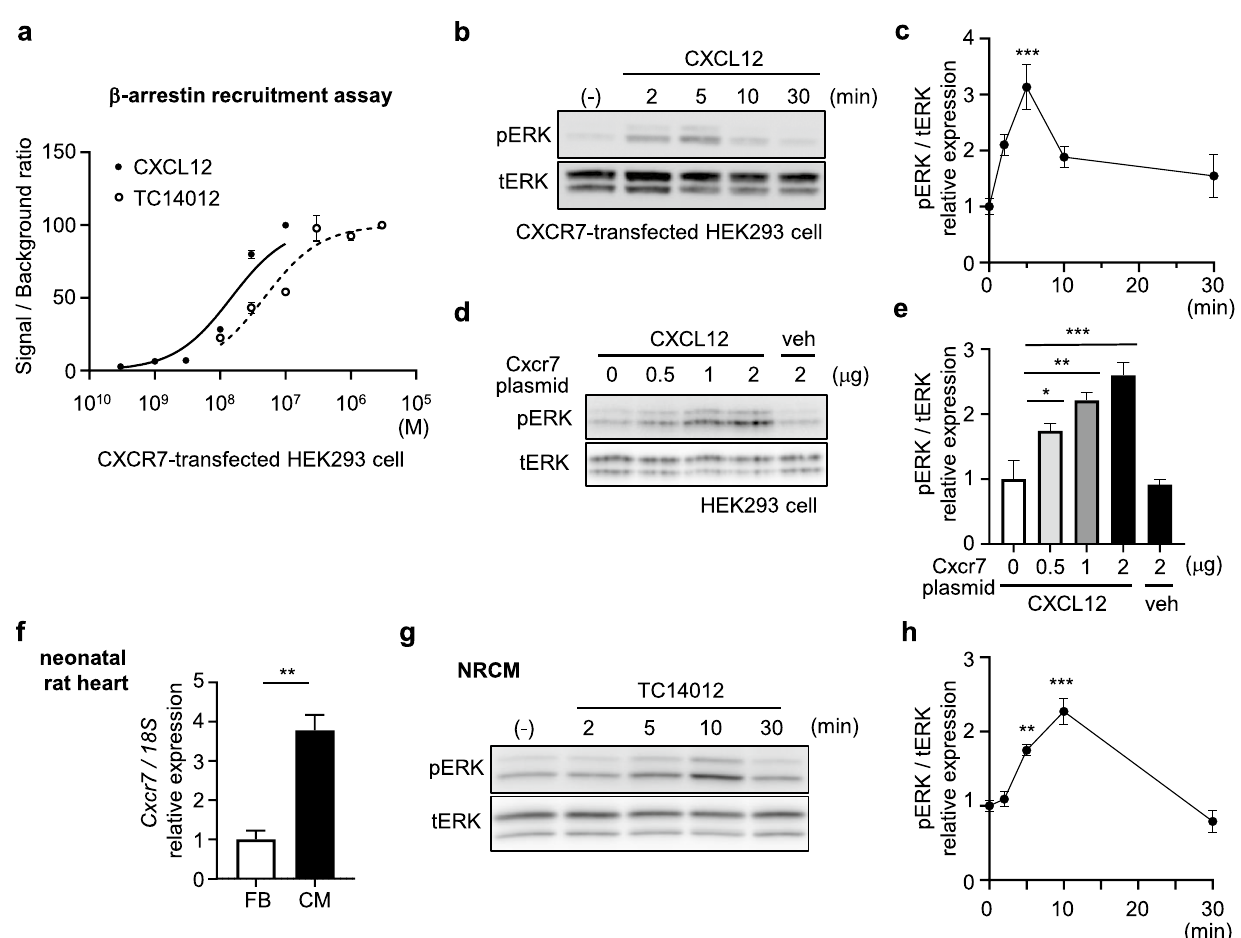
Figure 1. ERK is activated through CXCR7 in cardiomyocytes. ( a ) β-Arrestin recruitment assay of CXCR7 showing that CXCL12 and TC14012 induce coupling of CXCR7 with β-arrestin in a dose-dependent manner (EC 50 : 14.8 nM and 47.4 nM, respectively). Replicate samples are derived from independent HEK293 cells (n = 3). Data are shown as the mean ± SEM. ( b ) Immunoblot analysis of phosphorylated ERK (pERK) and total ERK (tERK) in HEK293 cells transfected with a CXCR7 expression plasmid at various time points after stimulation with CXCL12 (100 nM). ( c ) Quantitative data of the results shown in ( b ). n = 4. Data are shown as the mean ± SEM. Significance was calculated by ANOVA followed by the Bonferroni procedure; *** P < 0.001. Note that ERK was activated upon stimulation with CXCL12, and activity peaked at 5 min. ( d ) Immunoblot analysis of pERK/tERK in HEK293 cells transfected with various amounts of a CXCR7 expression plasmid with CXCL12 (100 nM) or vehicle (veh). Note that ERK was activated in a CXCR7 expression plasmid-dose- dependent manner under stable CXCL12 stimulation. ( e ) Quantitative data of the results shown in ( d ). n = 3. Data are shown as the mean ± SEM. Significance was calculated by one-way analysis of variance (ANOVA) followed by the Bonferroni procedure; * P < 0.05, ** P < 0.01, *** P < 0.001. ( f ) Cxcr7 mRNA expression in cardiomyocytes and fibroblasts from primary culture of neonatal rat hearts. Data are shown as the mean ±